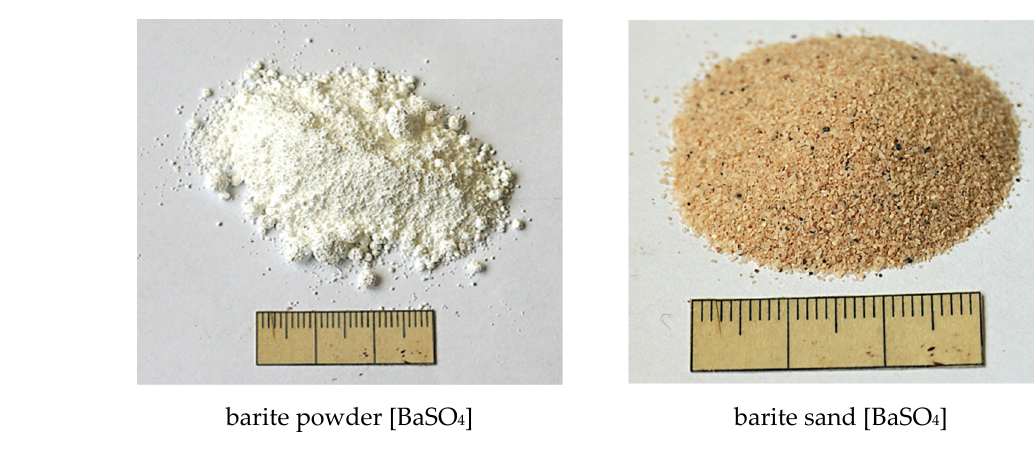
Figure 9. Particle size distribution of barite powder and barite sand. To determine the suitability of barite as powder and as sand, the influence on the change of the binder properties was determined on the one hand and the visibility in the µ-CT on the other. For this purpose, the two tracers were added using a high-performance mixer (see Figure 10). The addition of the individual amounts of tracer (see Table 3) was carried out at a speed of 700 rpm. This ensured that the tracer was evenly distributed in the emulsion and that no agglomerates formed.